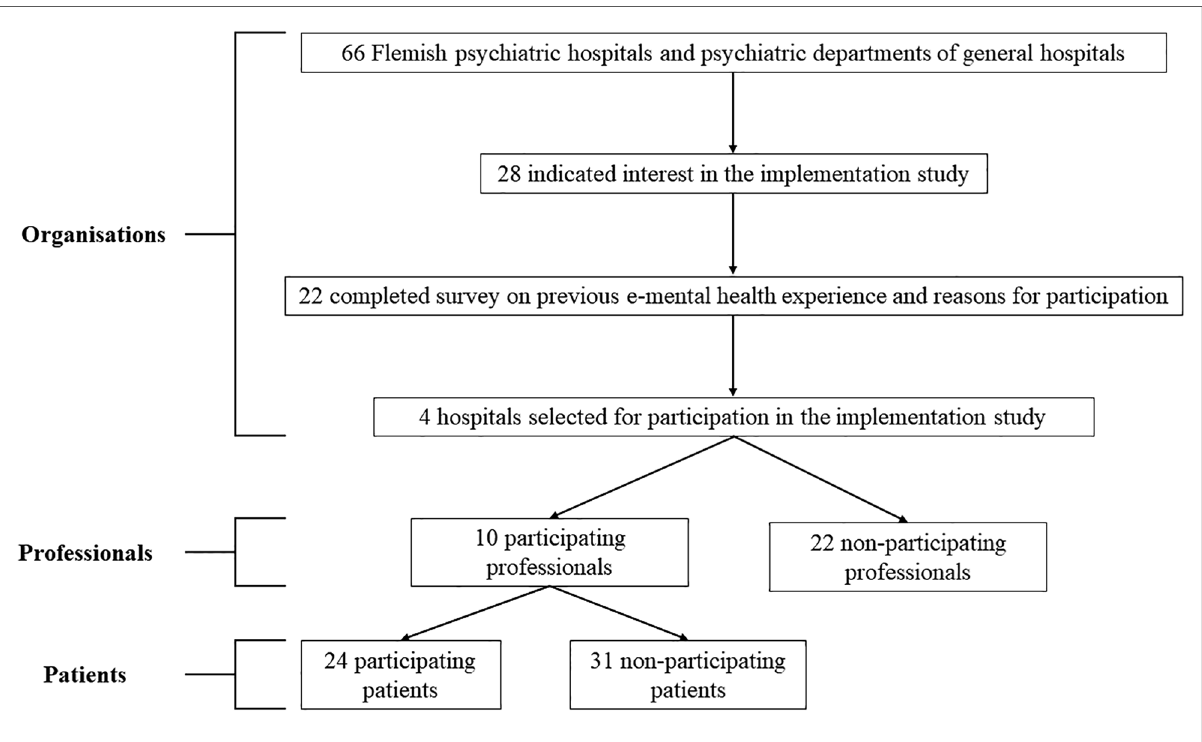
FIGURE 1 Participant fl ow